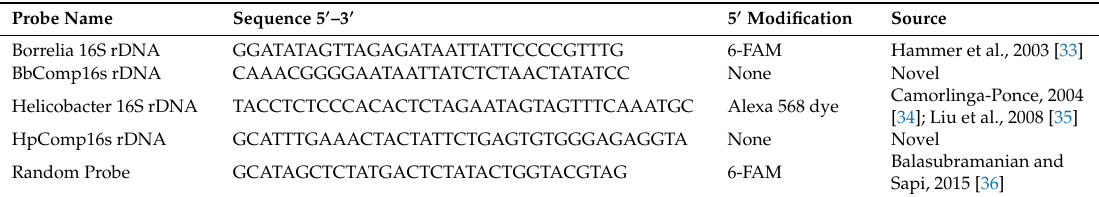
Table 3. Sequences of fluorescent in situ hybridization (FISH) probes for Bb and